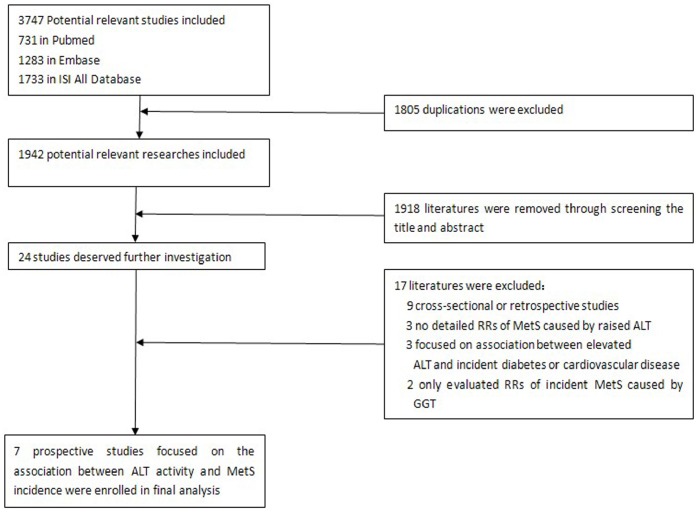
Flow chart of selected studies for meta-analysis.